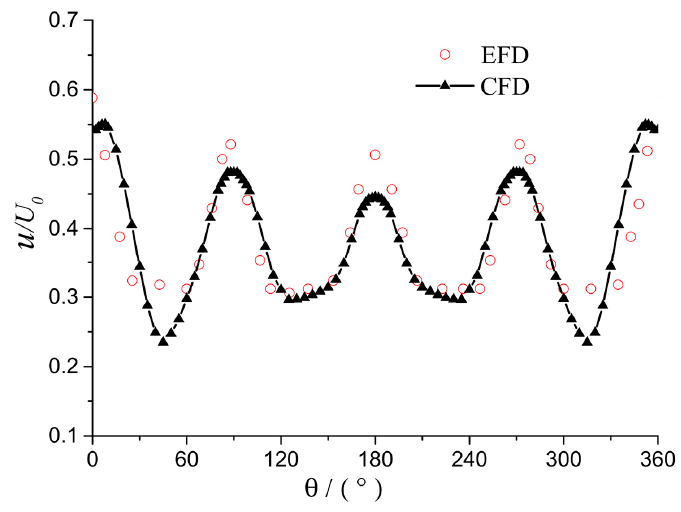
Figure 7. Axial wake friction at the propeller plane.